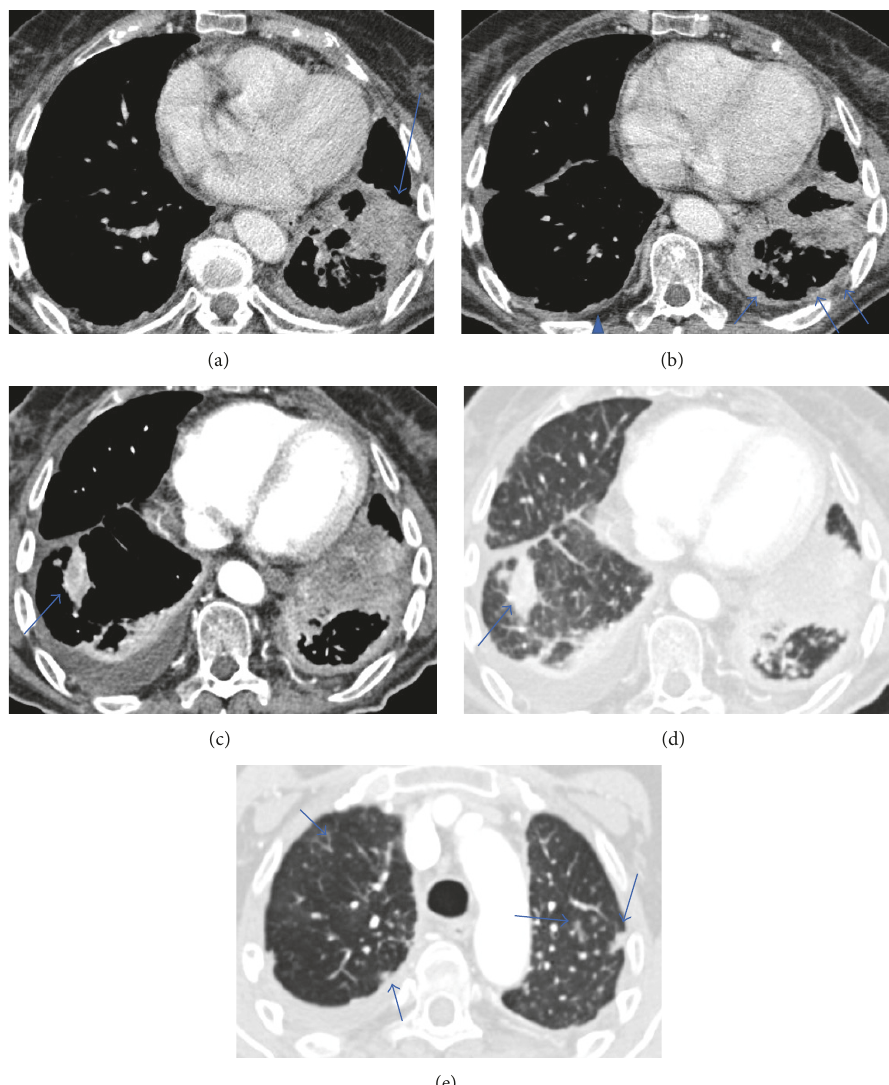
Figure 12: Chest CT. Multislice chest axial CT-images on mediastinal window (a, b, and c) show increase in size of the main lesion (a) and pleural metastases in the left side (arrows) and in contralateral side (arrowhead); a new lesion in the right lung is observed (arrow in (c)). Multislice chest axial CT-images on lung window (d and e) show the new contralateral lesion (arrow in (d)) and the parenchymal pulmonary nodules did not vary significantly in size from the previous studies (arrows in (e)).